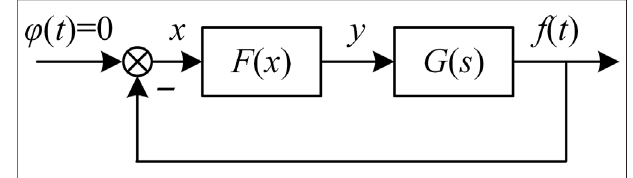
FIGURE 1 | Nonlinear SISO